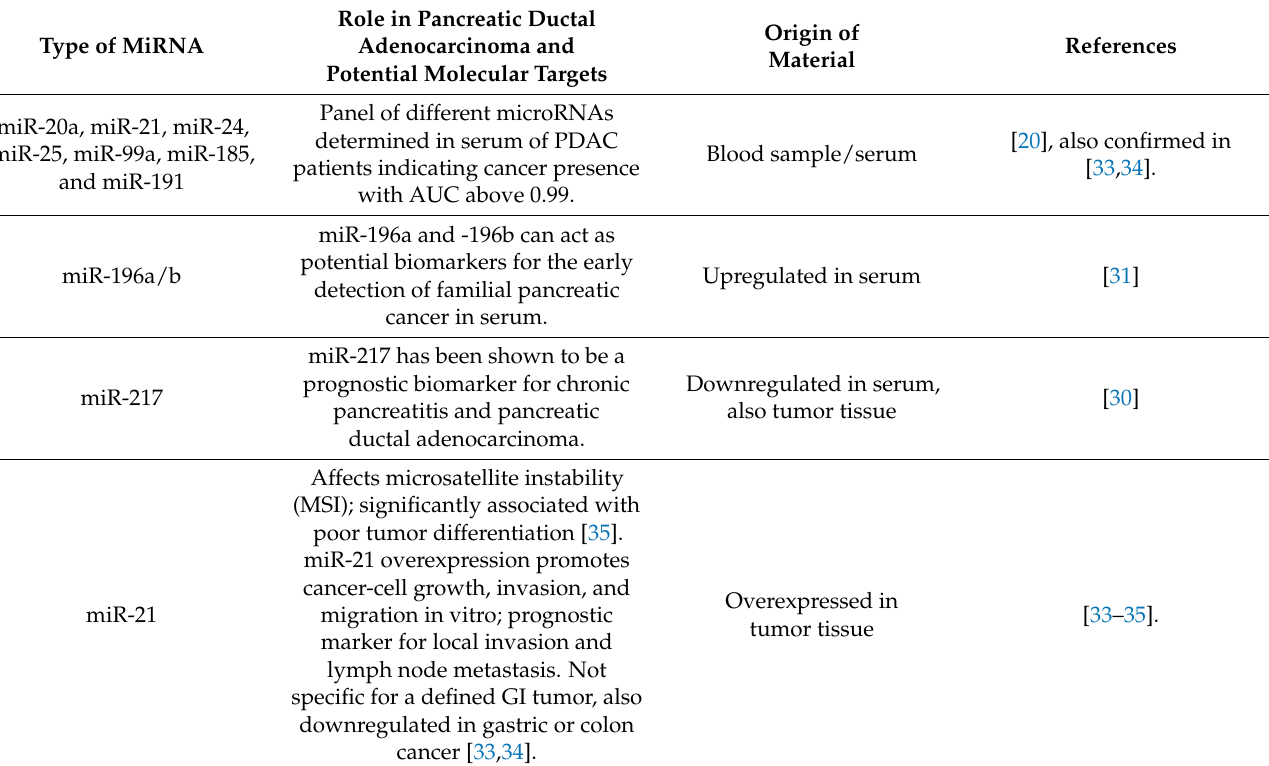
Table 1. Overview of dysregulated miRNAs involved in pancreatic ductal adenocarcinoma, as determined in different